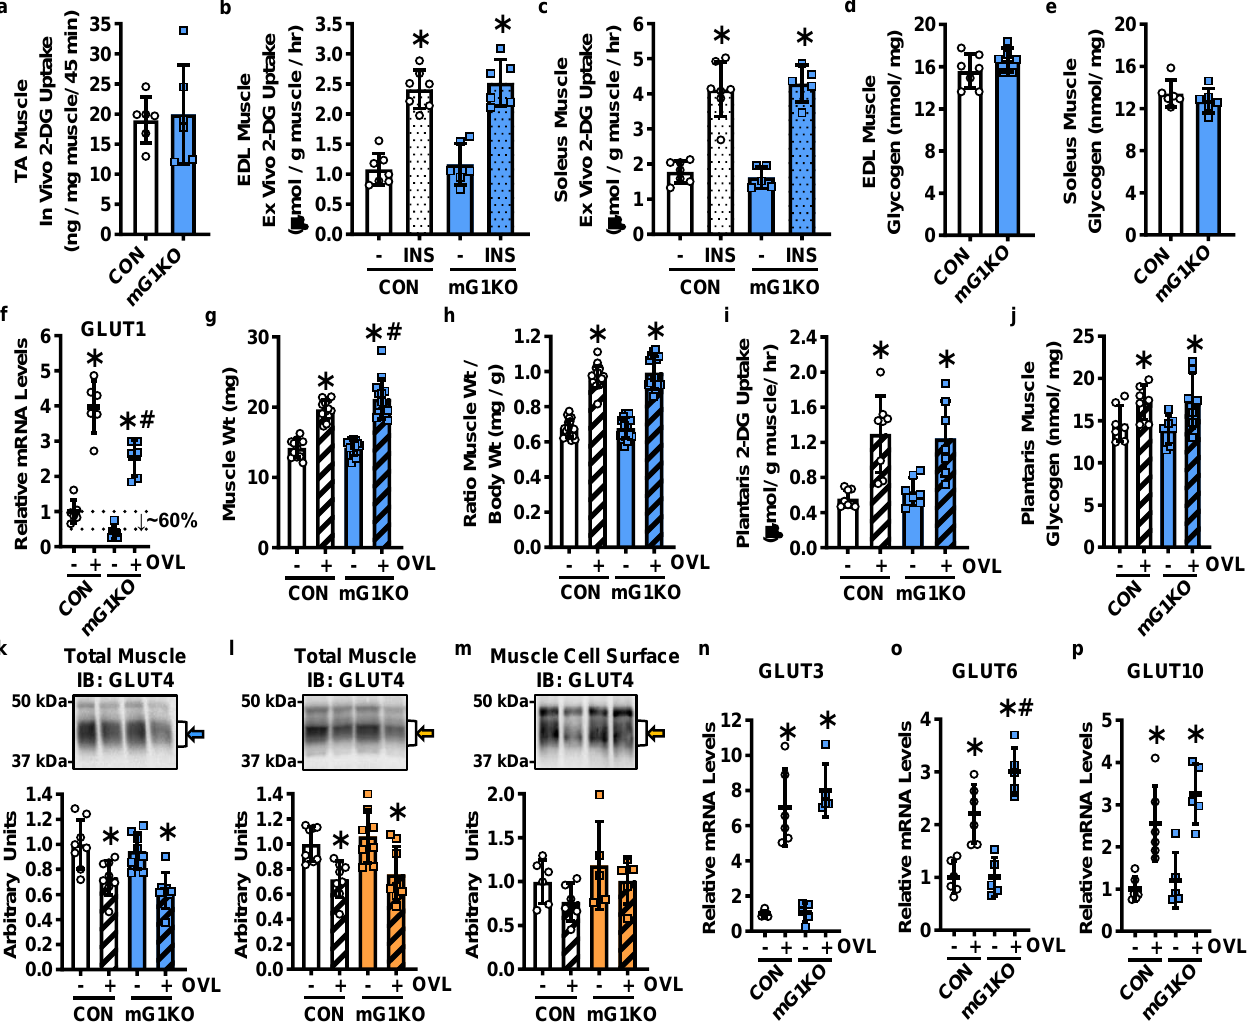
Figure 2. Effectofmuscle-specificGLUT1knockout(mG1KO)onskeletalmuscleglucoseuptake, glycogen content, and glucose transporter levels. ( a ) Female control (CON) and mG1KO mice were fasted overnight and anesthetized with pentobarbital sodium. Mice were injected with [ 3 H]-2-deoxyglucose (2-DG) and in vivo glucose uptake assessed in tibialis anterior (TA) muscles. N = 6 muscles/group. ( b , c ) Ex